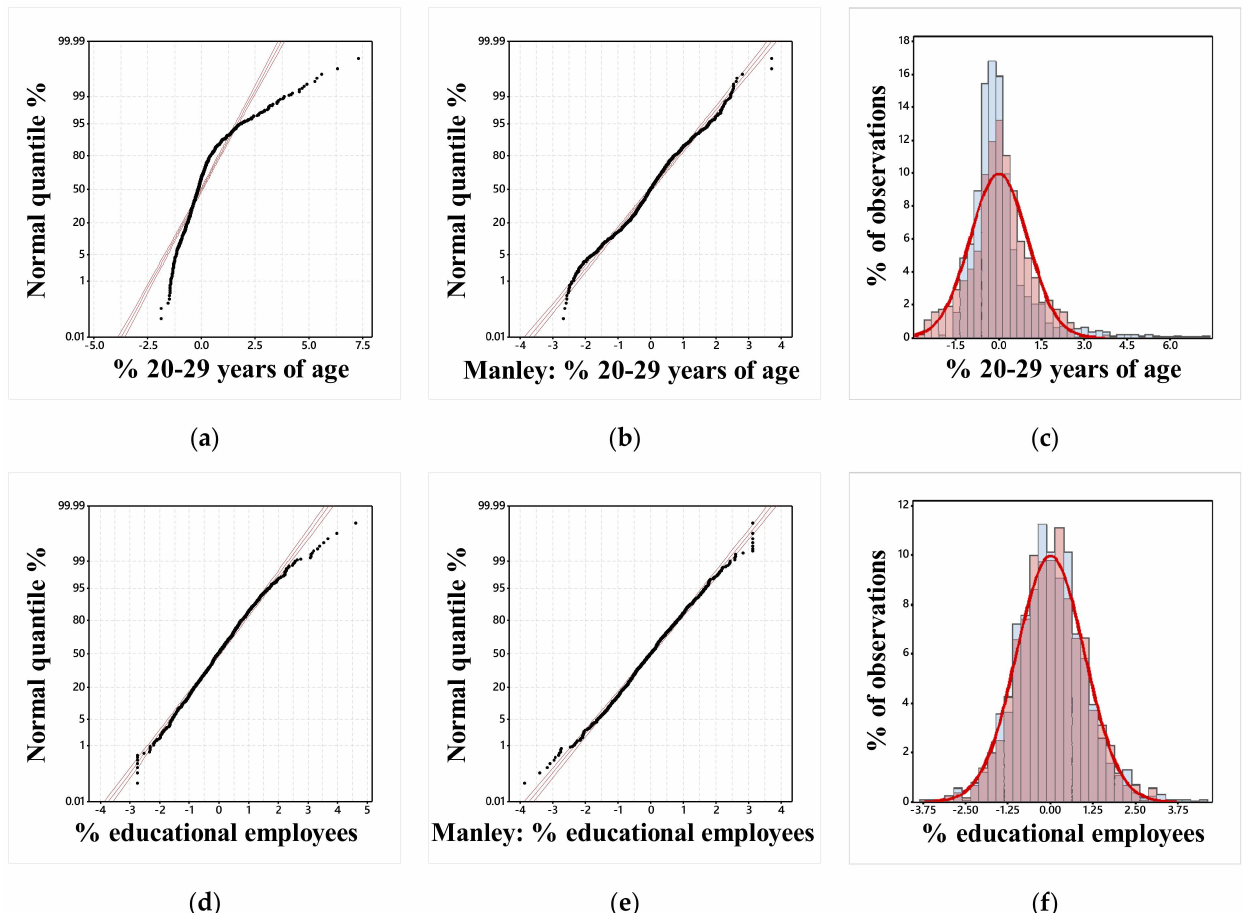
Figure 1. Normal quantile (red lines denote 95% confidence intervals and trendlines) and histogram portrayals for two Manly transformation extreme cases appearing in Table 4. Top left ( a ): raw DFW% age cohort. Top middle ( b ): Manly transformed DFW% age cohort. Top right ( c ): overlaid DFW% age cohort variates with superimposed bell-shaped curve. Bottom left ( d ) raw DFW% employment category. Bottom middle ( e ): Manly transformed DFW% employment category. Bottom right ( f ): overlaid DFW% employment category variates with superimposed bell-shaped